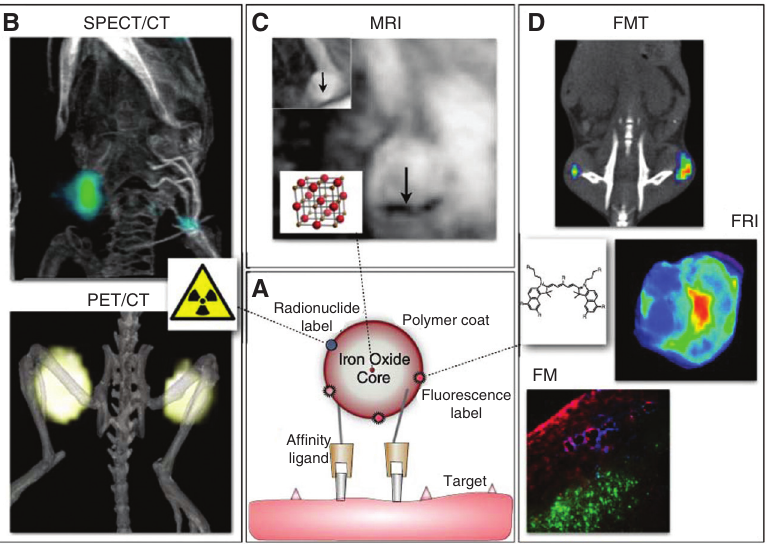
Figure 5 Concept of a multimodal iron oxide nanoparticle. (A) Iron oxide core is engulfed by a polymer shell (e.g., dextran). Amine groups bind affinity ligands and beacons for various imaging modalities (B–D). (B) Surface derivatization with radionuclides promotes nuclear imaging, e.g., positron emission tomography (PET, nanoparticles targeting tumor-associated macrophages) or single-photon emission